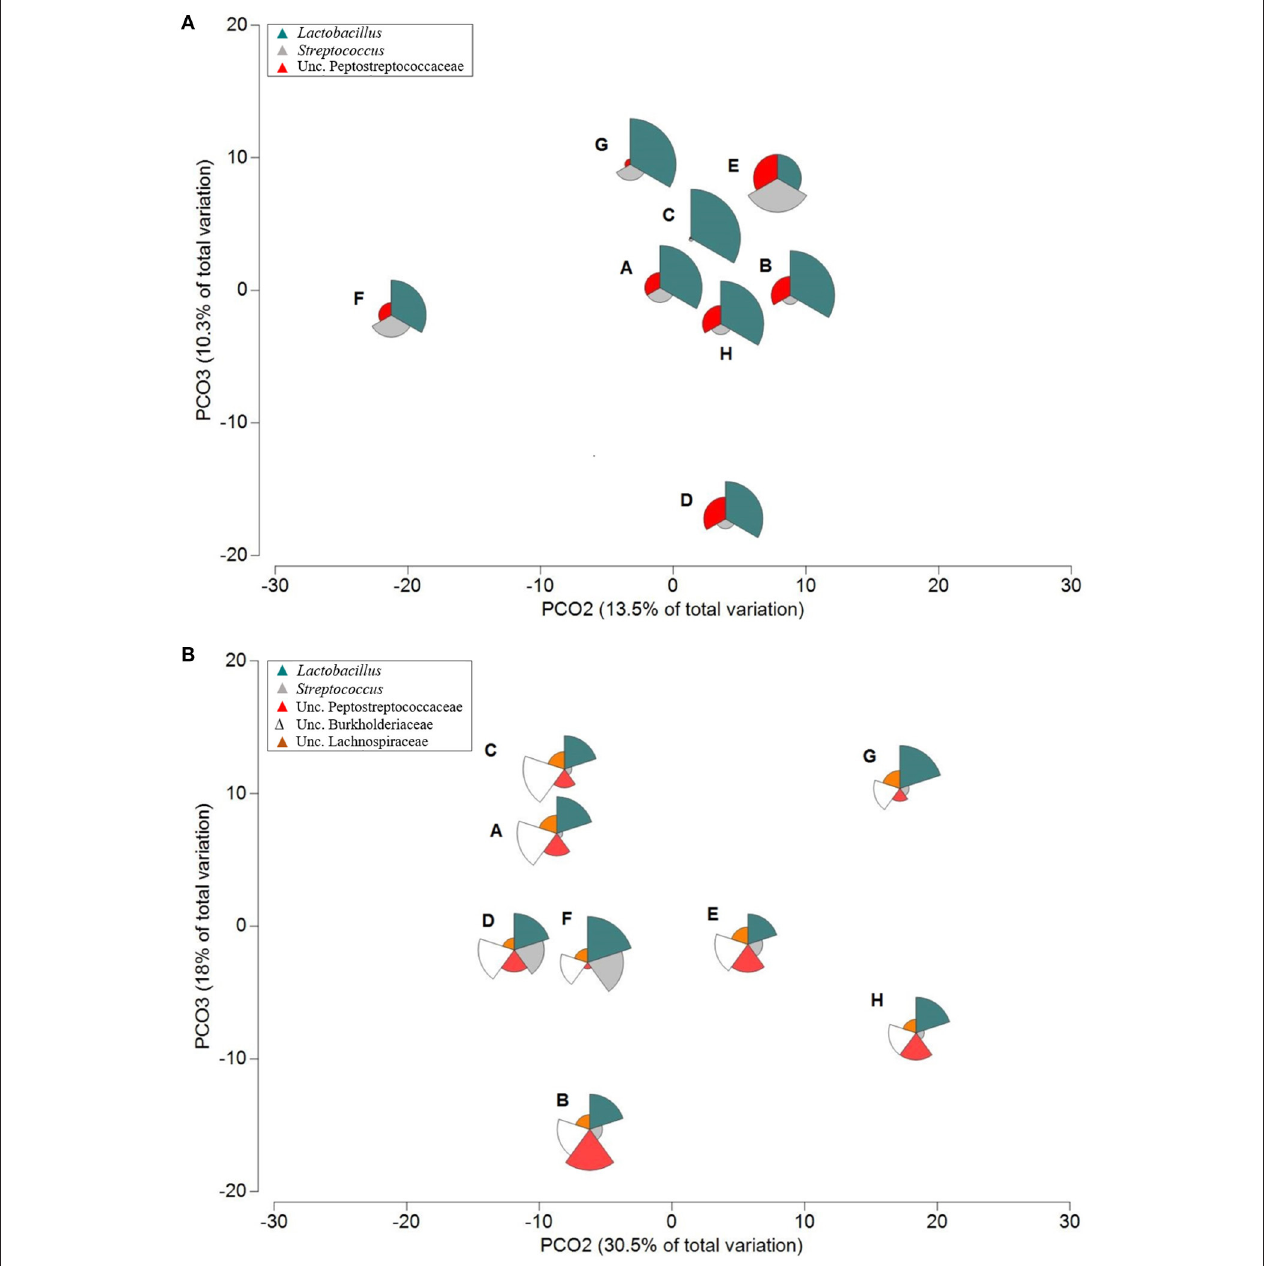
FIGURE 4 | Principal coordinate analysis (PCoA) ordination of the global bacterial community structure of ileum (A) digesta and (B) mucosa samples across eight dietary treatments (A–H) ( Table 1 ). Bubbles were superimposed to visualize the relative abundance of the most relevant genera, Lactobacillus and Streptococcus and families, Peptostreptococcaceae, Burkholderiaceae, and Lachnospiraceae (slice scale 1–100% abundance).